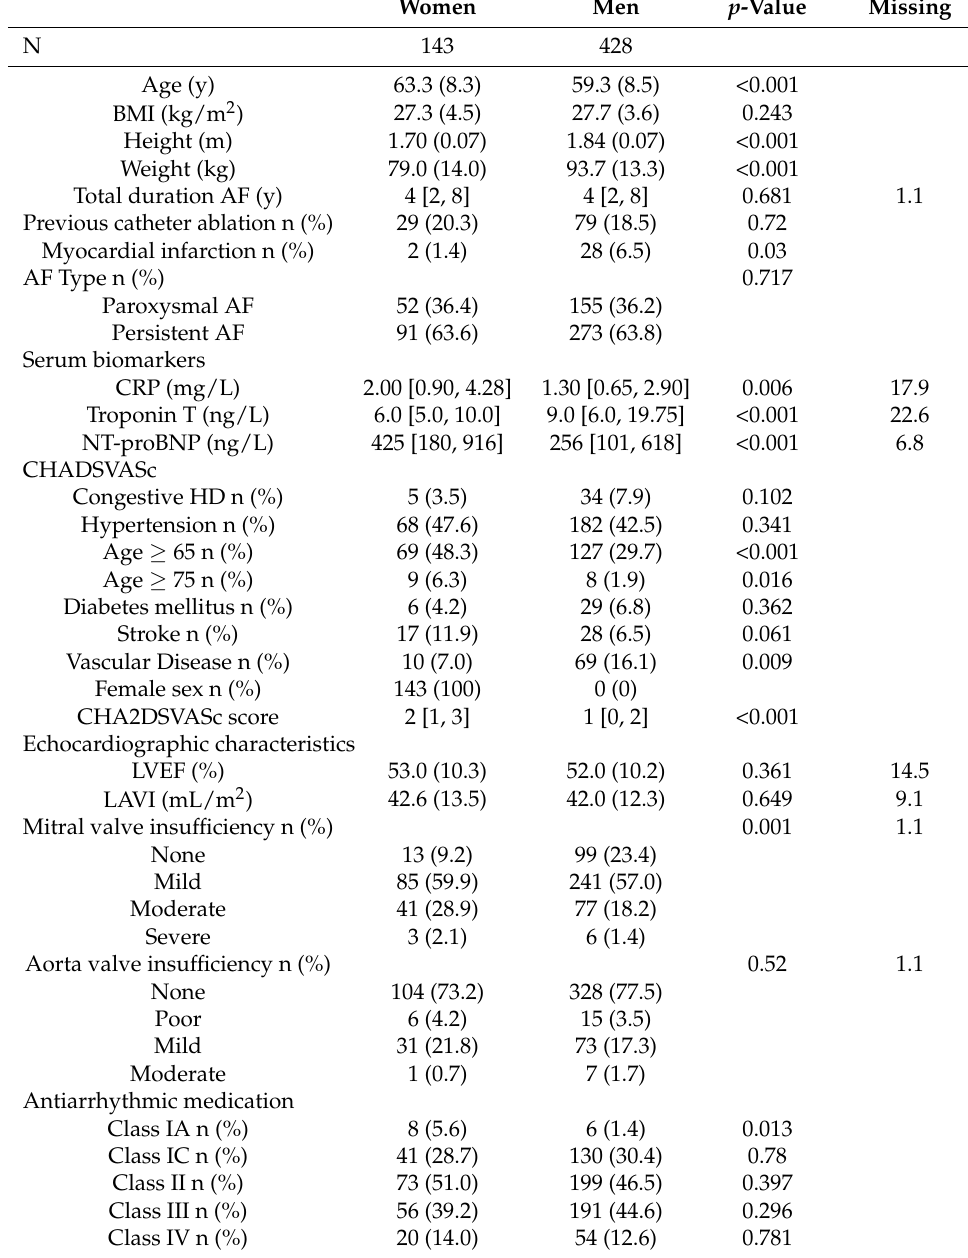
Table 1. Baseline